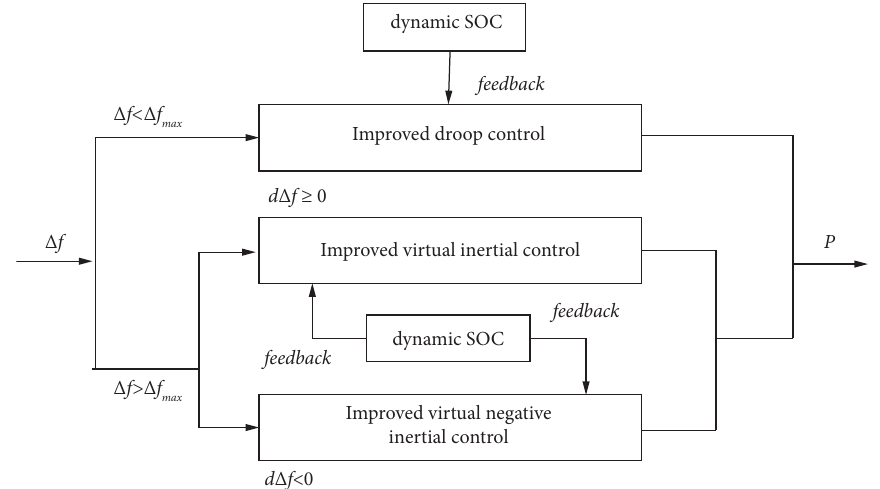
Figure 3: Integrated control